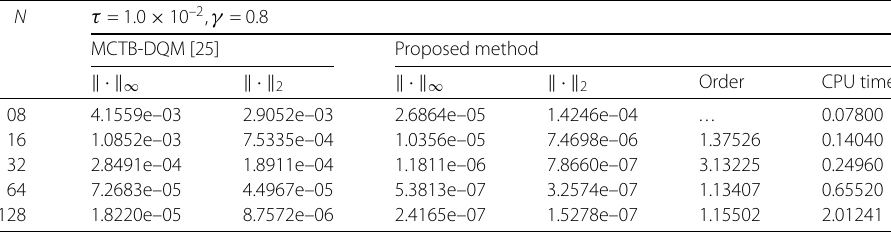
Table 3 A comparison of maximum error ( (cid:10) · (cid:10) ∞ ) and Euclidean norm ( (cid:10) · (cid:10) 2 ) at T = 1 for problem-1 N τ = 1.0 × 10 –2 , γ = 0.8